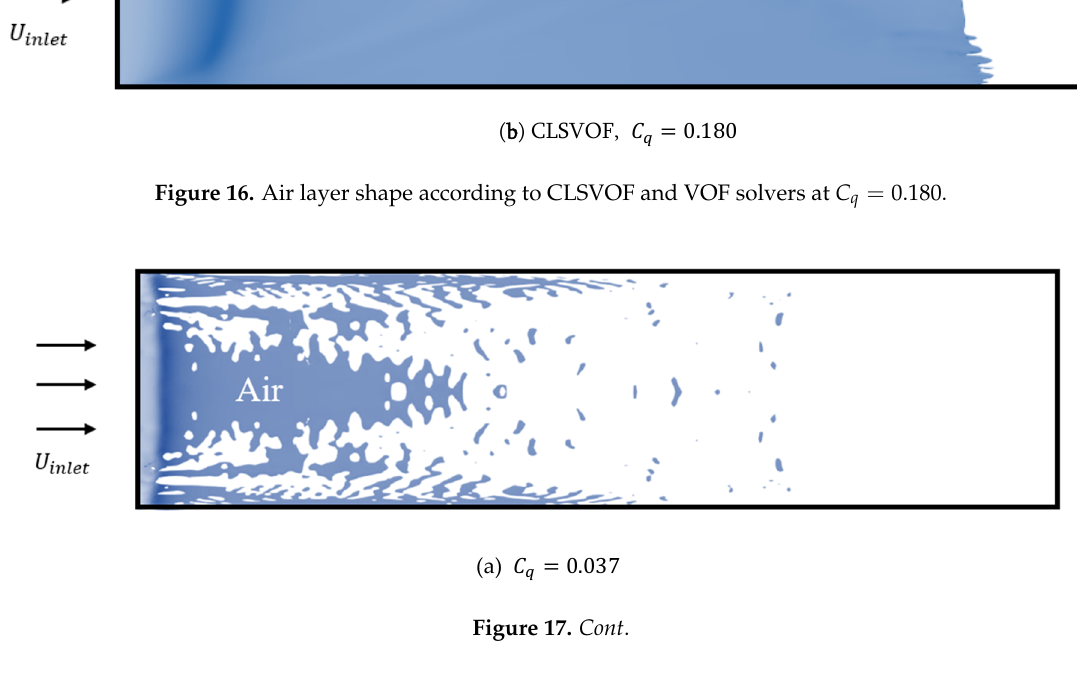
Figure 16. Air layer shape according to CLSVOF and VOF solvers at 𝐶 (cid:3044) = 0.180 .